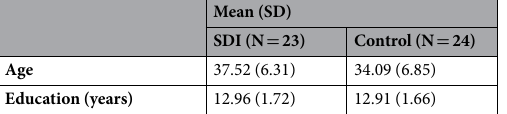
Table 3. Demographics (mean age and years of education) for participants in the SDI and control